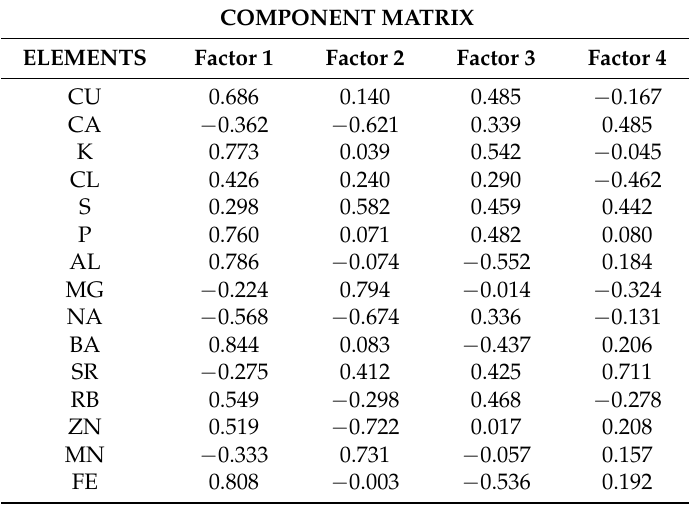
Table 4. Rotated matrix solution of elemental composition based on tree bark bioaccumulation studies.